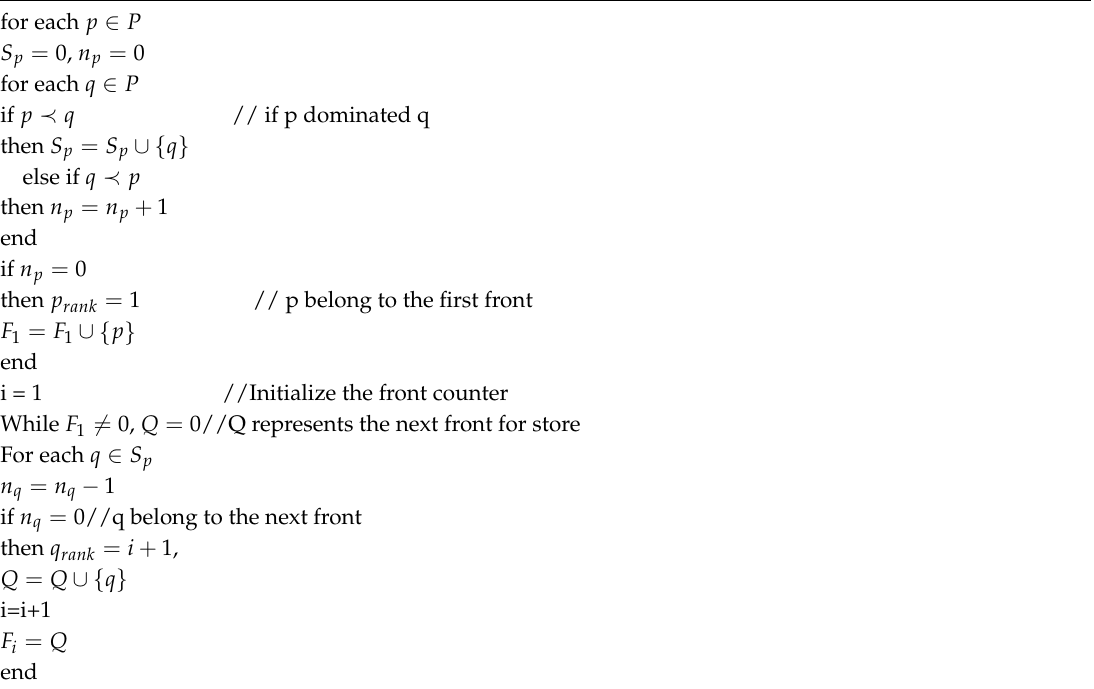
Algorithm 1: Fast non-dominated sort